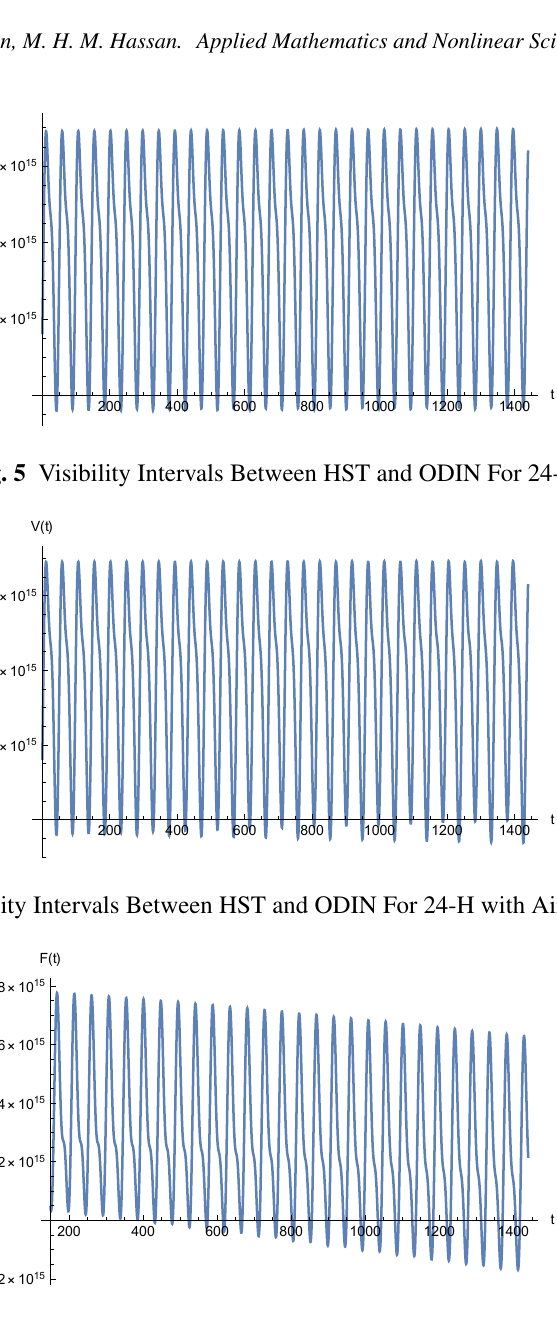
Fig. 7 Visibility Intervals Between CFESAT and MTI For